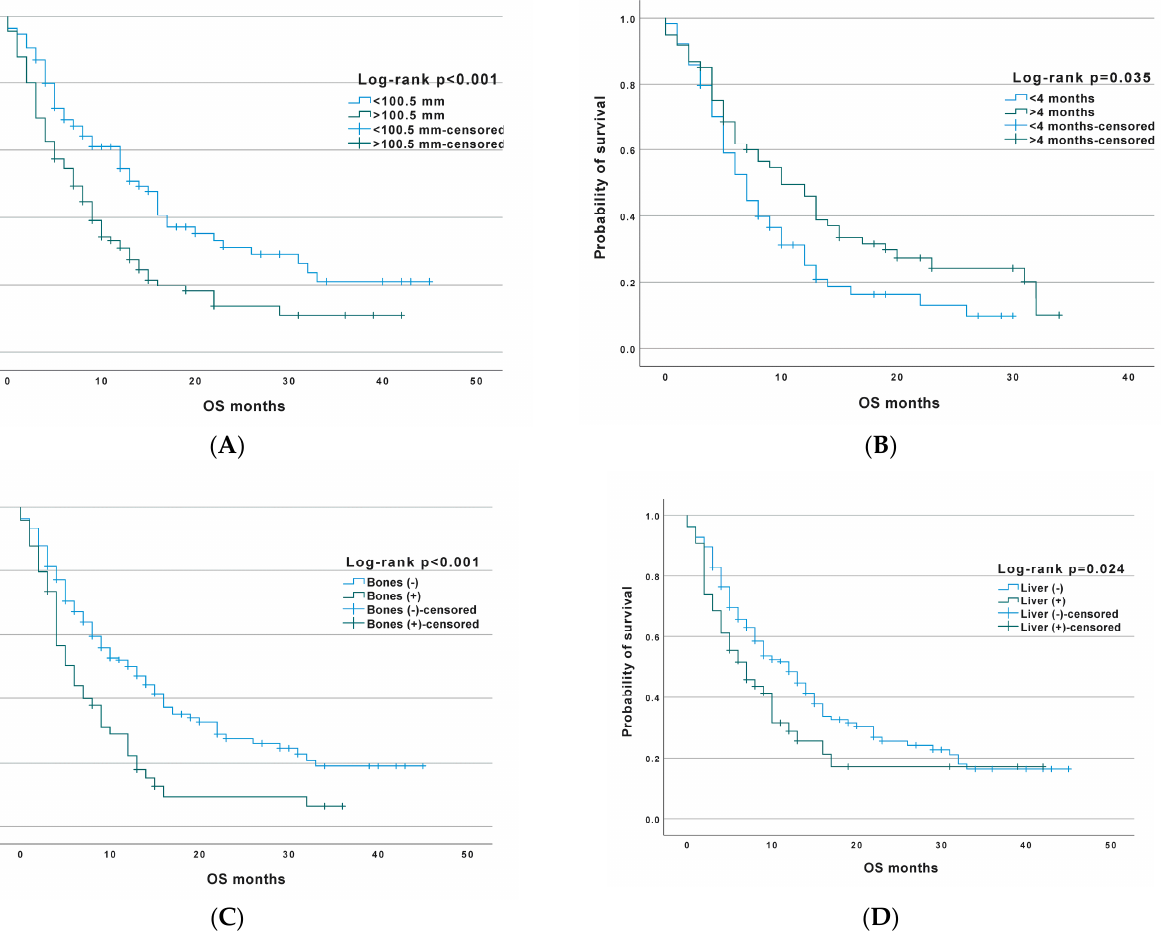
Figure 2. Overall survival among all patients in correlation to clinical factors: ( A )—tumour diameter, ( B )—time of response to chemotherapy, ( C )—bone metastases, and ( D )—liver metastases.